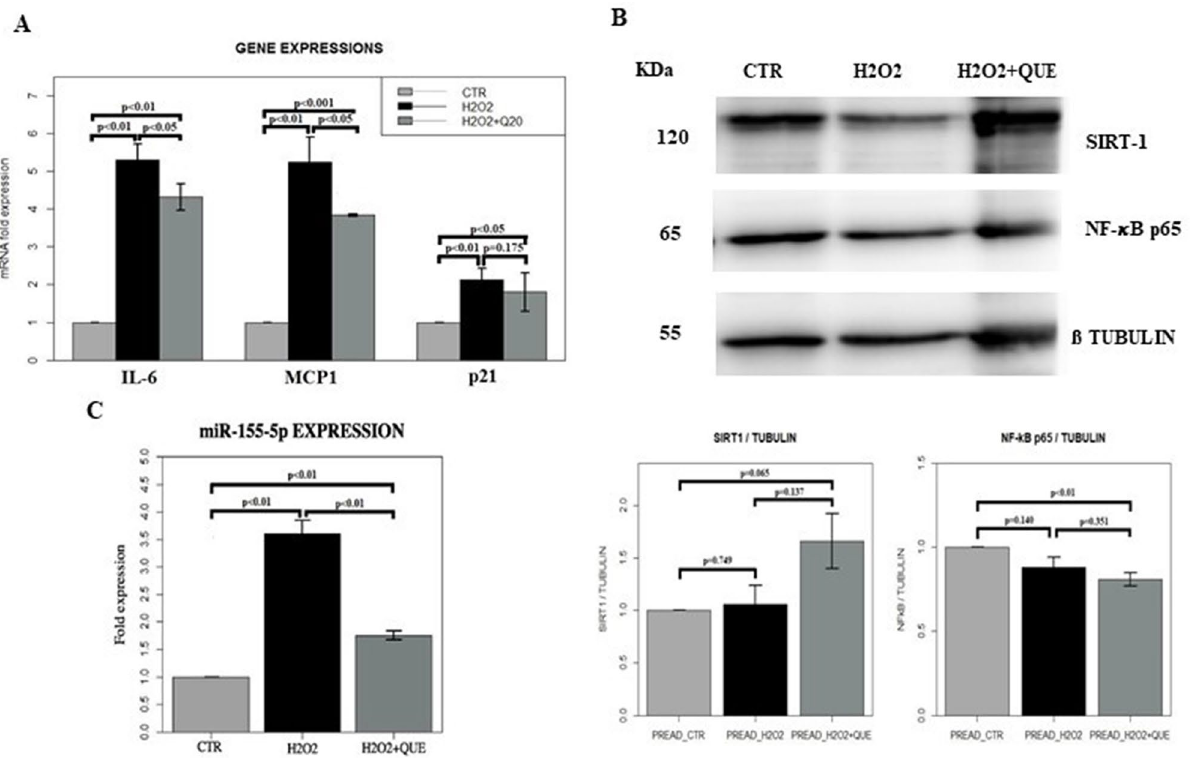
Figure 6. ( A ) Gene expression profile of pre-adipocytes (PREAD-CTR), pre-adipocytes treated with H 2 O 2 (PREAD-H2O2) and pre-adipocytes treated with H 2 O 2 plus quercetin (PREAD-H2O2 + QUE). IL-6 = interleukin-6, MCP1 = monocyte chemoattractant protein 1, p21 = cyclin-dependent kinase inhibitor 1. ( B ) Cropped blots and densitometric analysis from western blotting assay of SIRT1 and NF-κB p65 normalized on β-tubulin in pre-adipocytes (CTR), pre-adipocytes treated with H 2 O 2 (H2O2) and pre-adipocytes treated with H 2 O 2 plus quercetin (H2O2 + QUE). The values are represented as mean ± SE. SIRT1 = silent regulator information 1, NF-κB = nuclear factor kappa-light-chain-enhancer of activated B cells. For full length membranes please refer to Supplementary Fig. 2C, D. ( C ) Histograms showing the expression of miR-155-5p in pre-adipocytes (CTR), pre-adipocytes treated with H 2 O 2 (H2O2) and adipocytes treated with H 2 O 2 plus quercetin (H2O2 + QUE). SIRT1 = silent regulator information 1, NF-κB = nuclear factor kappa-light-chain- enhancer of activated B